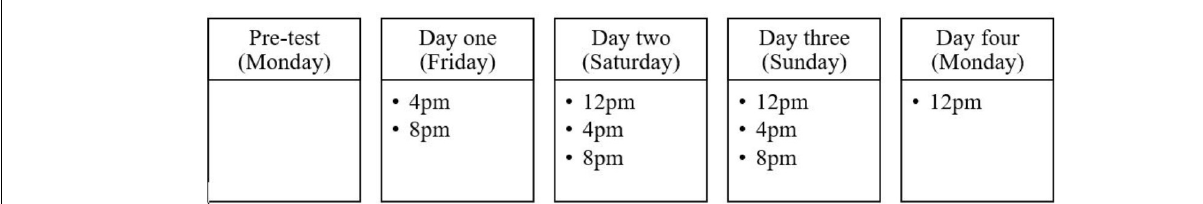
FIGURE 1 | Progression model illustrating the experimental design.